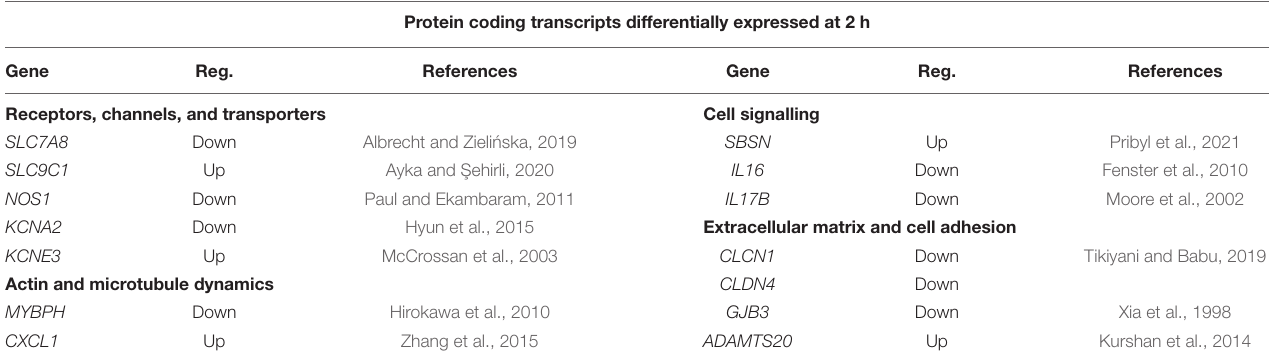
TABLE 3 | RNA sequencing data selection of protein coding genes differentially expressed after 2 h incubation with 1 nM sAPP α and their functions. Protein coding transcripts differentially expressed at 2